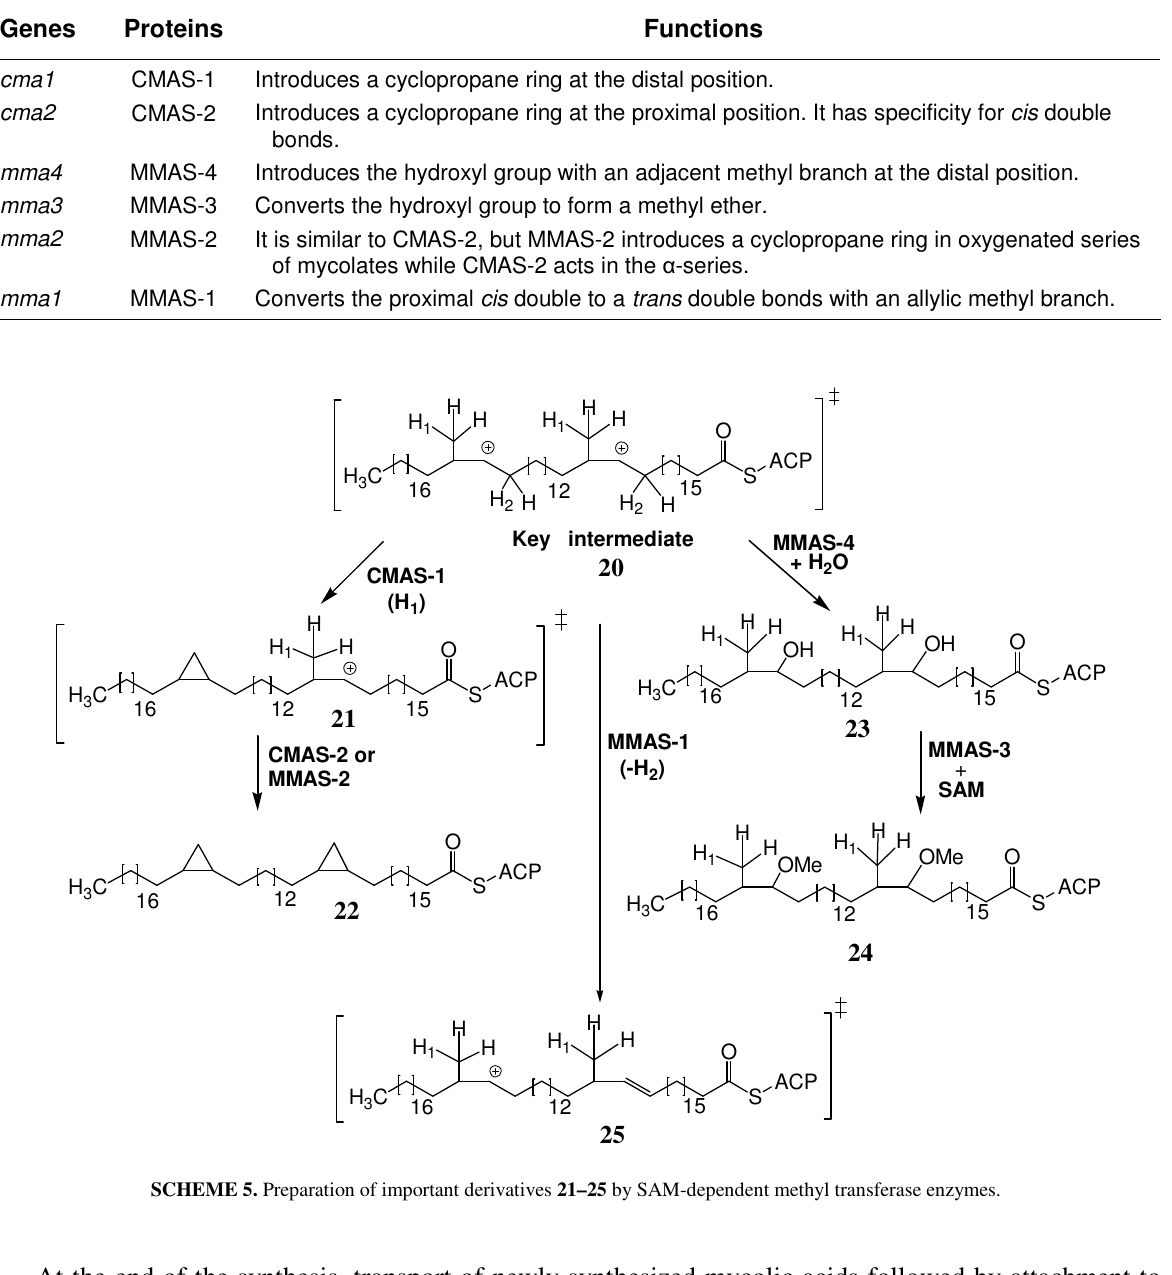
Responsible Genes and Proteins for Modifications in the Mero Chain, after the Desaturation